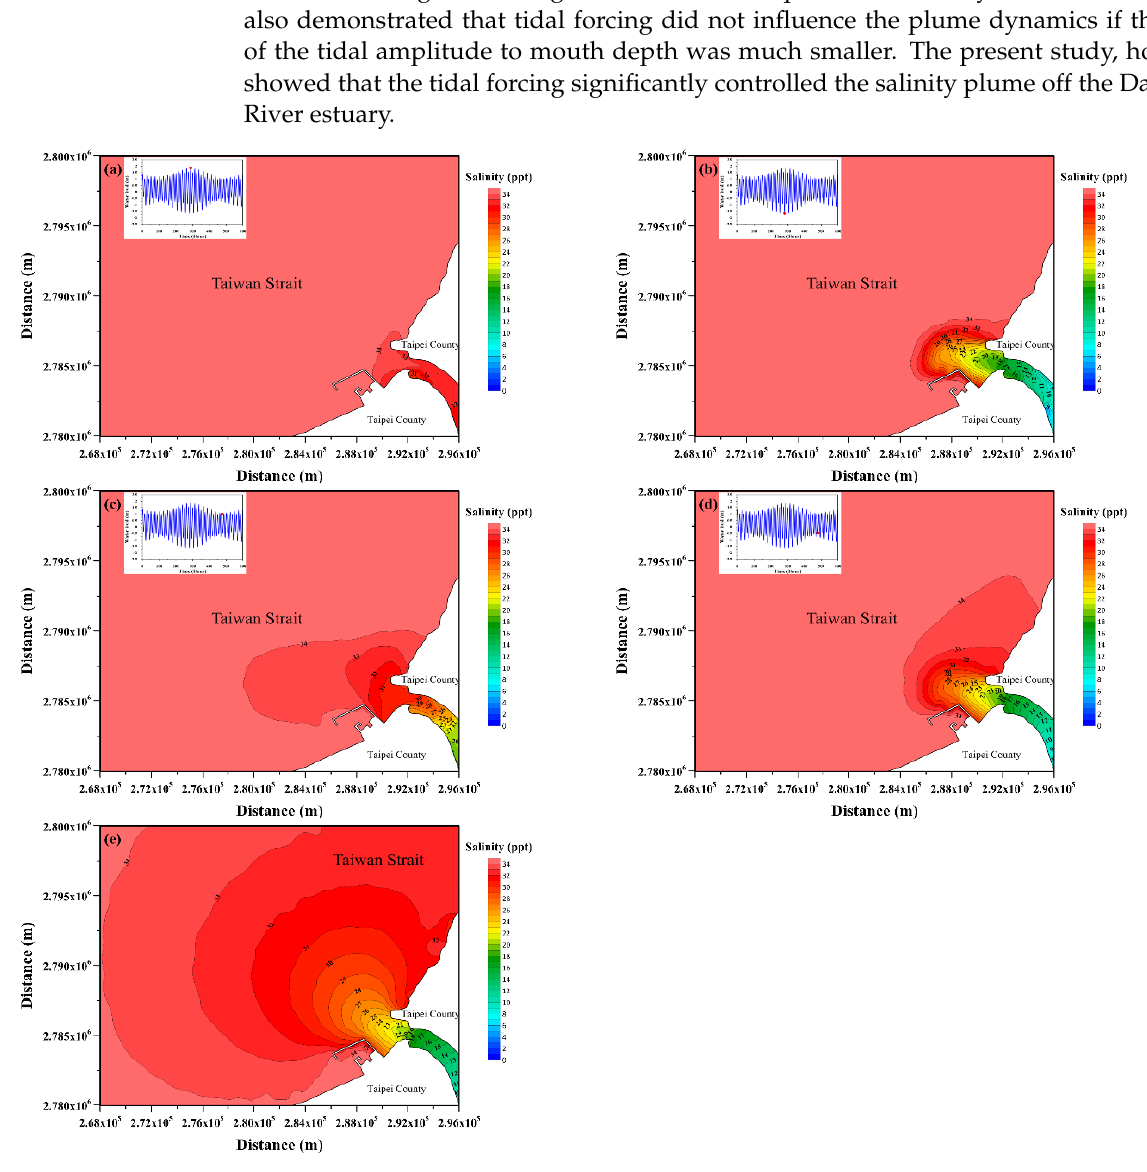
Figure 9. Surface salinity distributions under mean flow conditions for different tidal actions: ( a ) spring tide with high slack tide, ( b ) spring tide with low slack tide, ( c ) neap tide with high slack tide, ( d ) neap tide with low slack tide, and ( e ) without tidal effects.